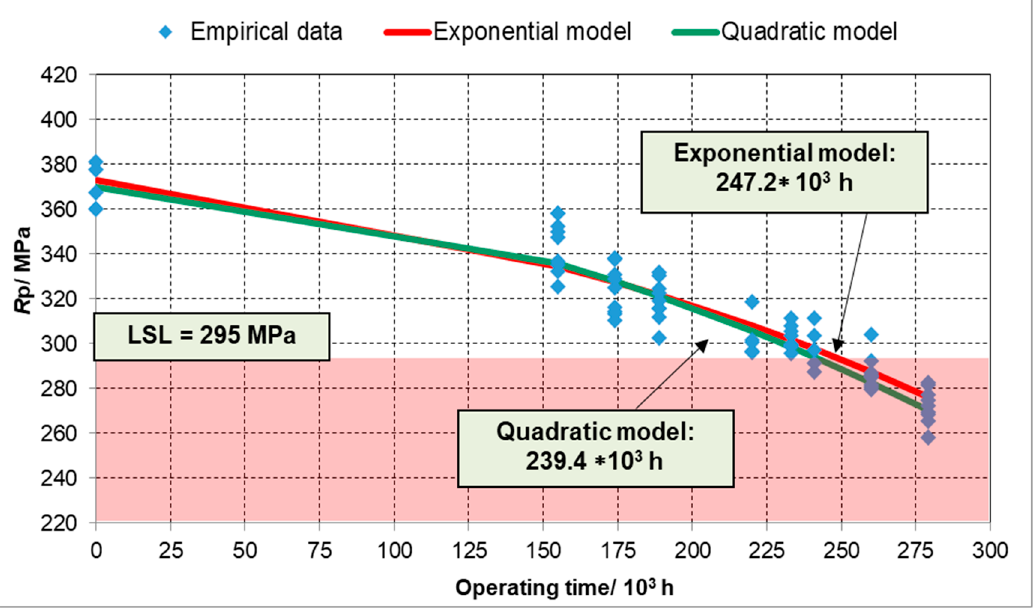
Figure 3. The course of the R p change depending on the operating time for the elbow bend made of FS group steel at the longitudinal location of the samples tested.